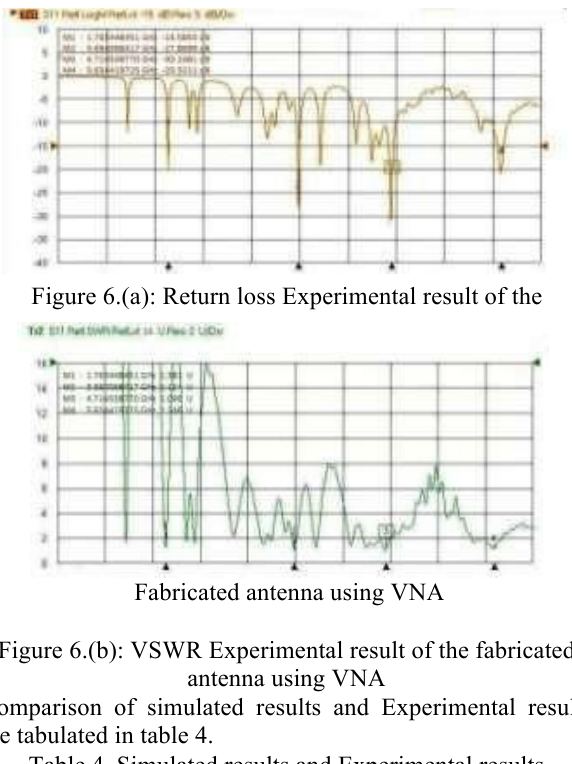
Figure 6.(a): Return loss Experimental result of the